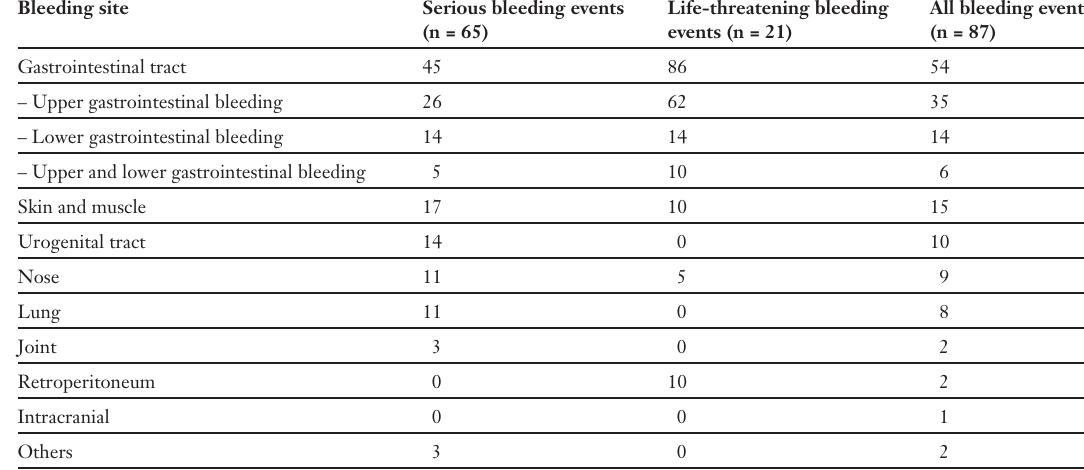
Table 3 Sites of bleeding (all variables in